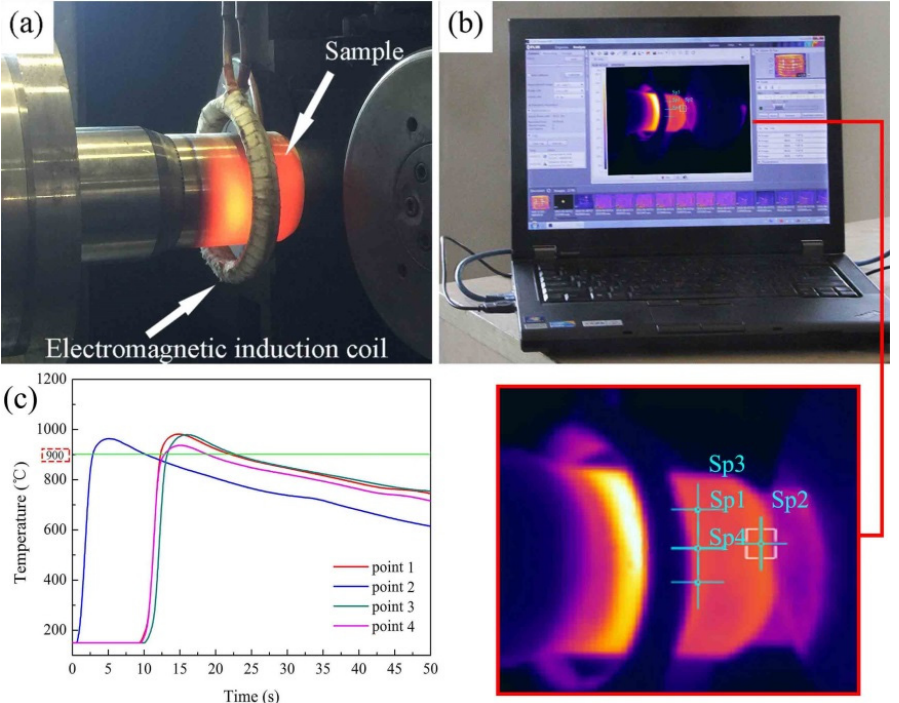
Figure 2. The apparatus of electromagnetic induction heating system for hot power spinning: ( a ) electromagnetic induction heating, ( b ) infrared temperature monitoring system, ( c ) and time- temperature curve during hot power spinning.